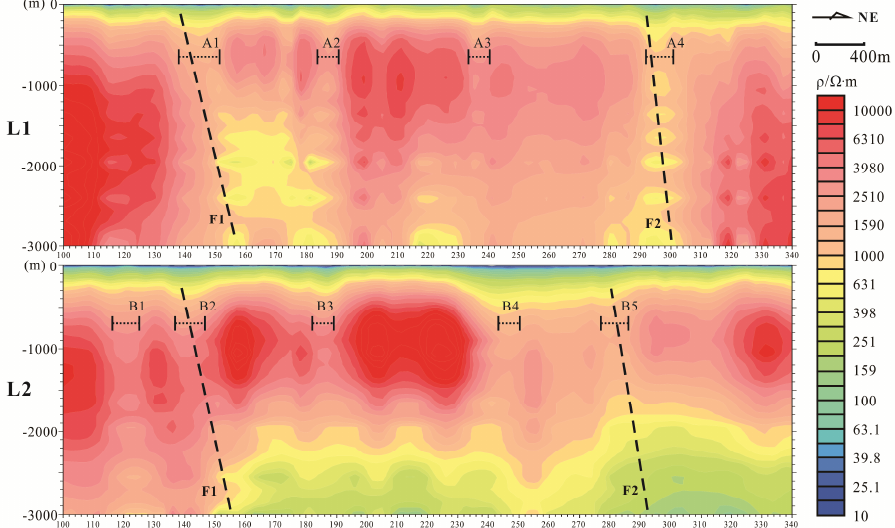
Figure 7. Controlled source audio magnetotelluric sounding (CSAMT) detection results.